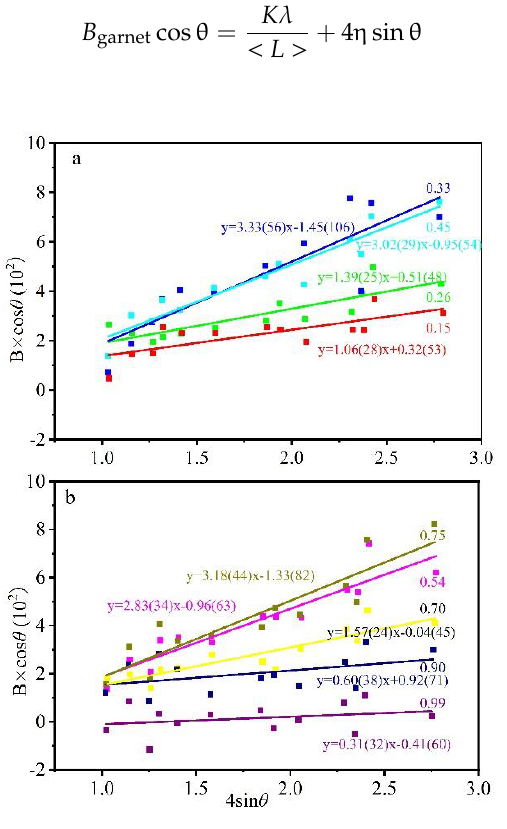
Figure 9. Williamson–Hall plot for XRD peak widening data of grossular–andradite solid solution. The number represents the mole fraction of andradite component. The slope of equation represents the microstrain factor ( η ). ( a ) grossular-rich samples; ( b ) andradite-rich